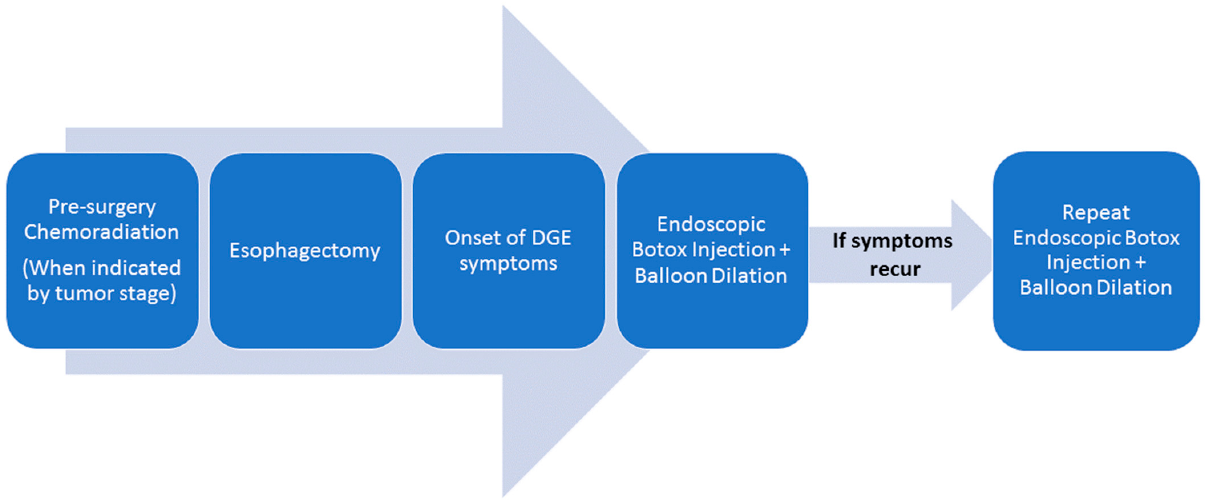
Figure 1. Treatment course for delayed gastric emptying.